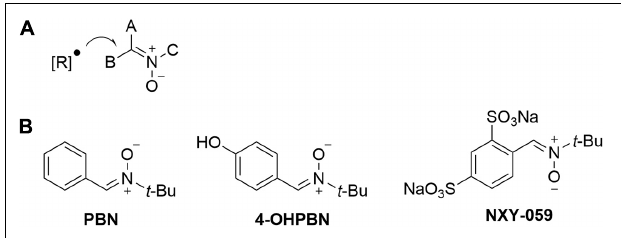
FIGURE 1 | (A) Reaction of a free radical [R] • with a nitrone. (B) Structures of nitrones PBN, 4-OHPBN and